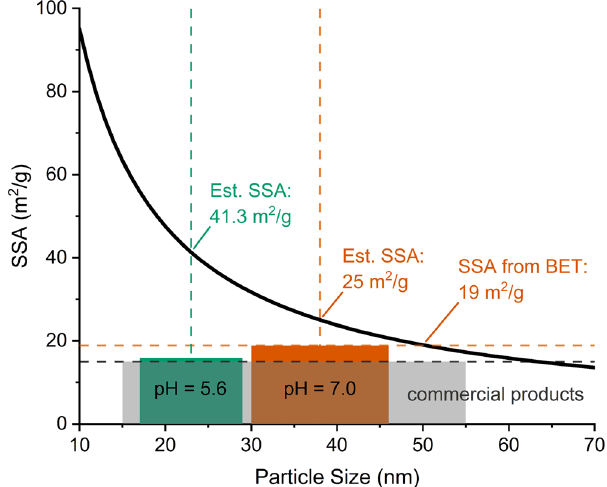
Figure 8. Calculated theoretical SSA for CuO particles of different diameters and experimental results obtained in the present study for different synthesis conditions. Indicated are the theoretical SSAs for particles obtained from the measured crystallite size as well as the SSAs measured with BET. For comparison the SSA indicated for typical commercial products is